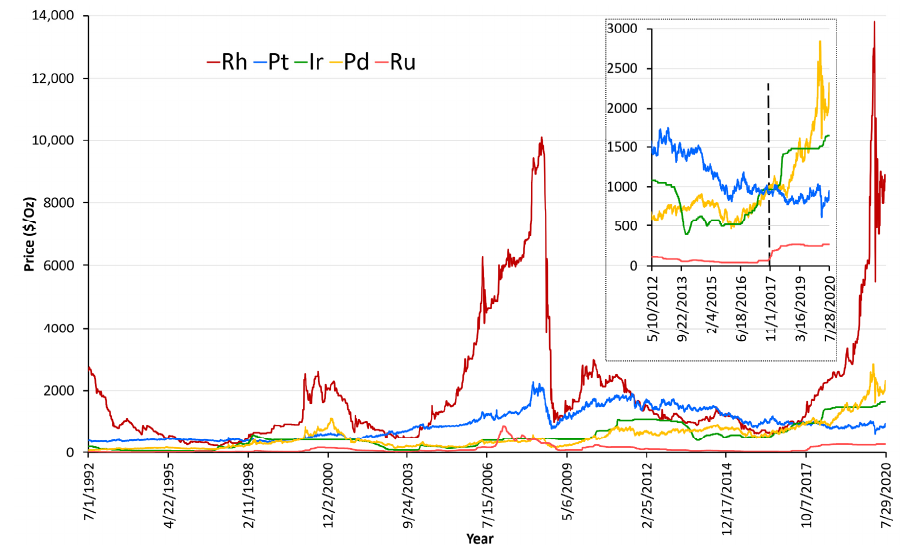
Figure 4. Historical PGM prices since 07/01/1992, data were accessed on 07-29-2020. Inset with dashed green border shows zoomed-in prices since 05/10/2012, Rh prices have been removed for clarity, dashed black vertical line in inset shows the time point when Pd prices became higher than Pt. Source: Johnson Matthey.